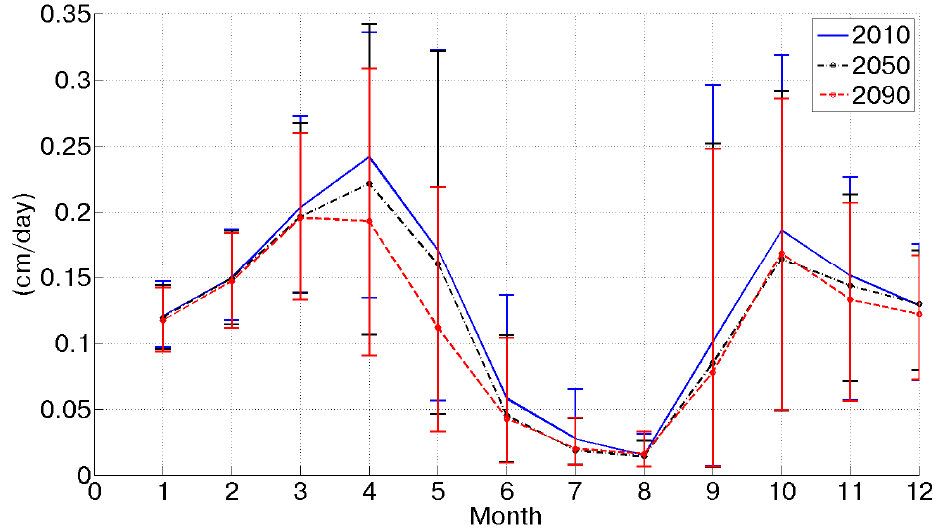
Figure 5. Mean daily actual evapotranspiration for each month limited by soil moisture availability in the three considered